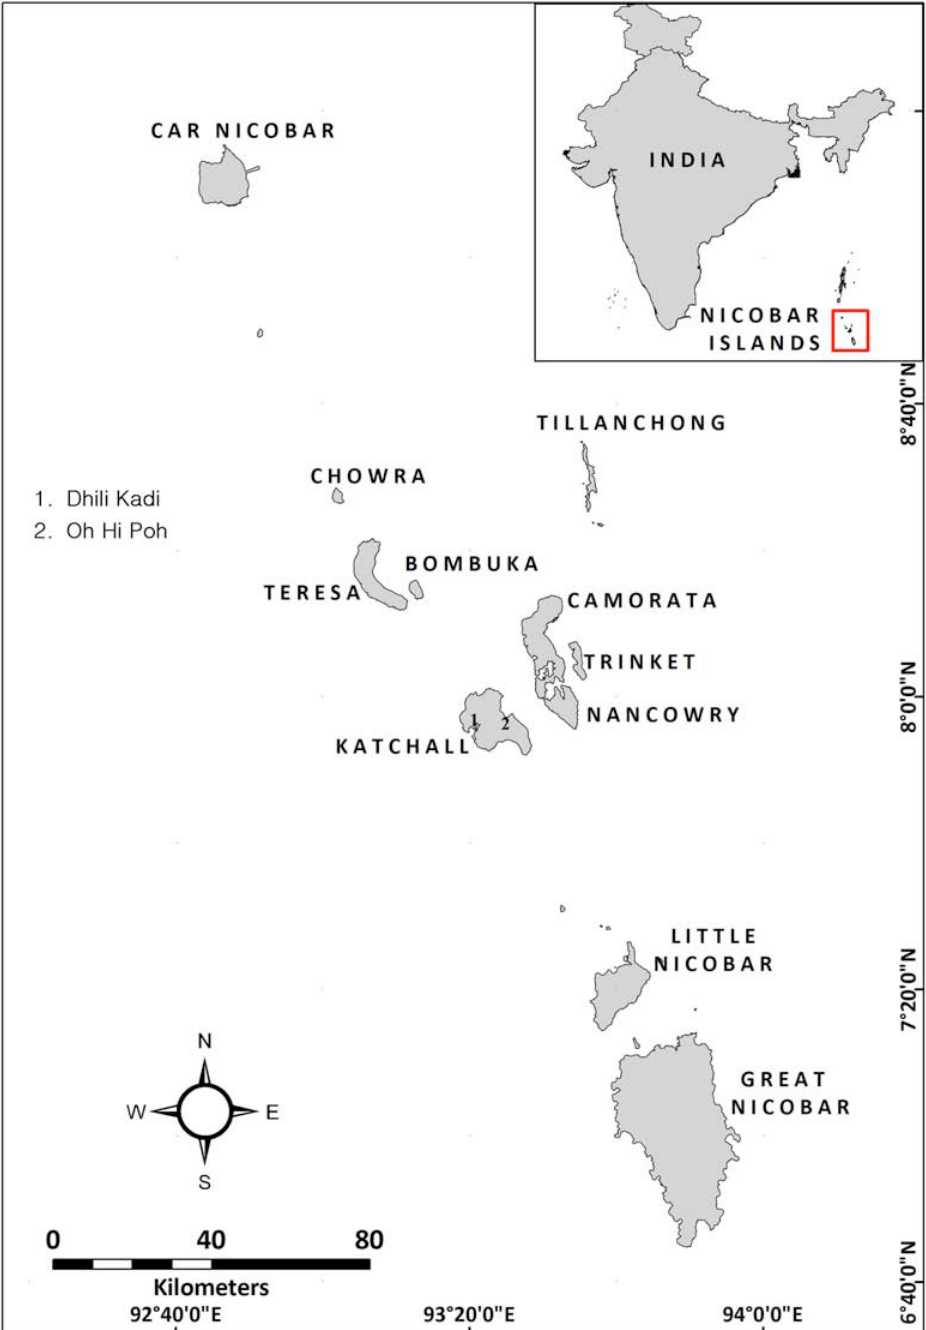
Figure 1. Nicobar Islands, India, showing the study localities, on Katchall Island, where Sonneratia ovata was observed: 1 - Dhili Kadi; 2 - Oh Hi Poh